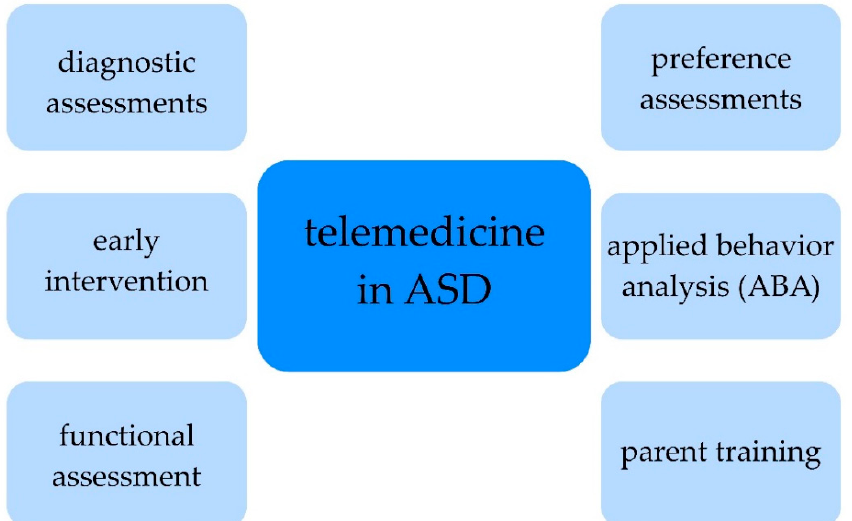
Figure 1. The use of telemedicine in children/adolescents diagnosed with ASD. Abbreviations: ASD, autism spectrum disorder; ABA, applied behavioral analysis. The figure shows the areas of use for telemedicine in children/adolescents with ASD and their caregivers, indicating its usefulness not only in the diagnostic or interventional processes but also in a wide therapeutic range or in assessing satisfaction with the provided